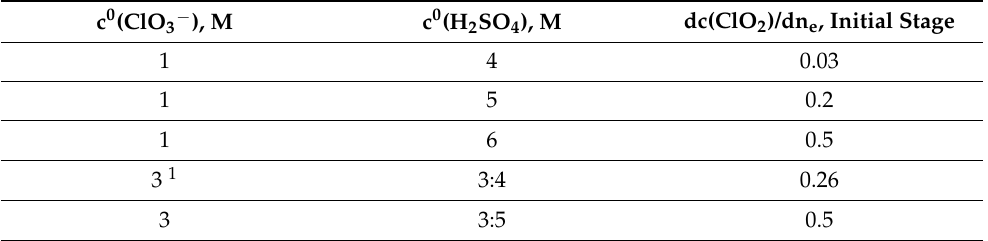
Table 3. Change in the number of ClO 2 molecules inside the catholyte per electron passed through the cell in the initial stage of the potentiostatic load test of the MEA cell for catholytes of various chlorate/acid molar